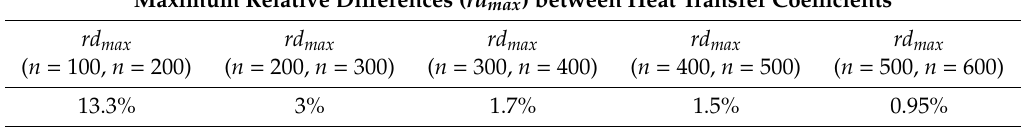
Figure 5. The influence of the mesh density on the values of the heat transfer coefficient; the experimental data obtained for the test section with five minichannels, q’’ = 13.8 kW/m 2 . Table 1. The values of the maximum relative differences ( rd max ) between heat transfer coefficients obtained from ADINA computations for adjacent values of n , the data for the test section with five minichannels, q’’ =13.8 kW/m 2 .